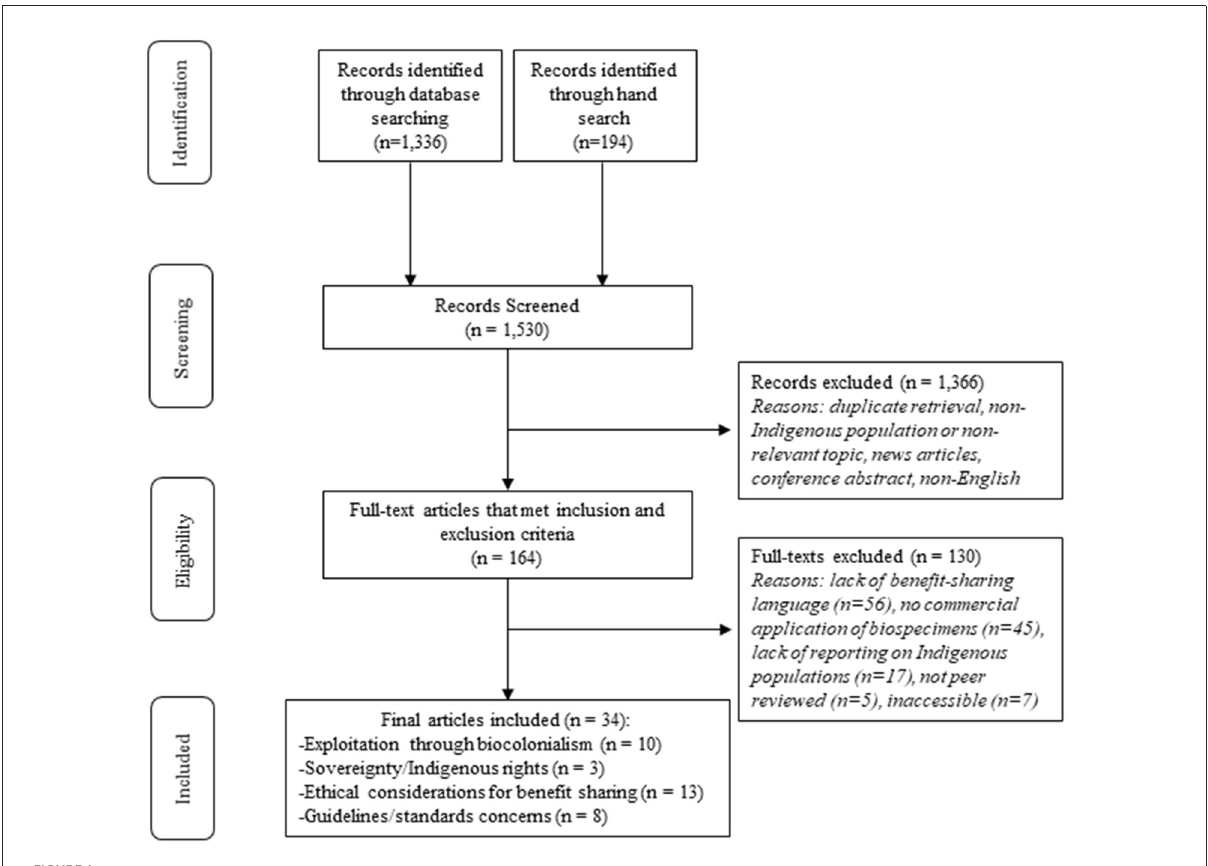
FIGURE1 Adapted PRISMA